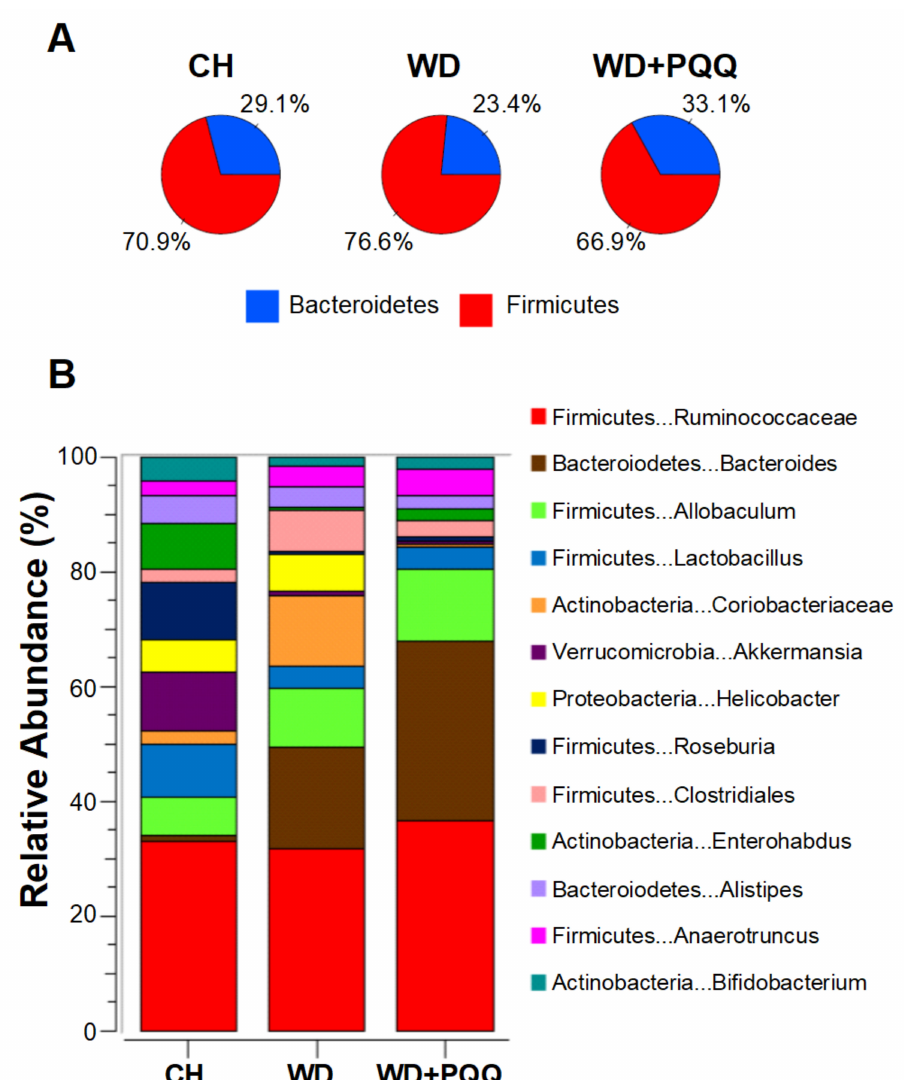
Figure 7. PQQ - associated changes in the gut microbiota of offspring of obese mouse dams. Obe- sity in dams was induced by feeding a chow (CH) or Western-style diet (WD), with and without PQQ supplementation. Bacterial compositional differences were measured using 16S sequencing of offspring cecal contents at postnatal day 21 [107]. ( A ) The ratio of Bacteroidetes to Firmicutes was diminished by WD exposure and rescued by PQQ. ( B ) WD exposure altered relative abundances of the 13 most abundant genera, some of which returned to near control levels in offspring exposed to maternal